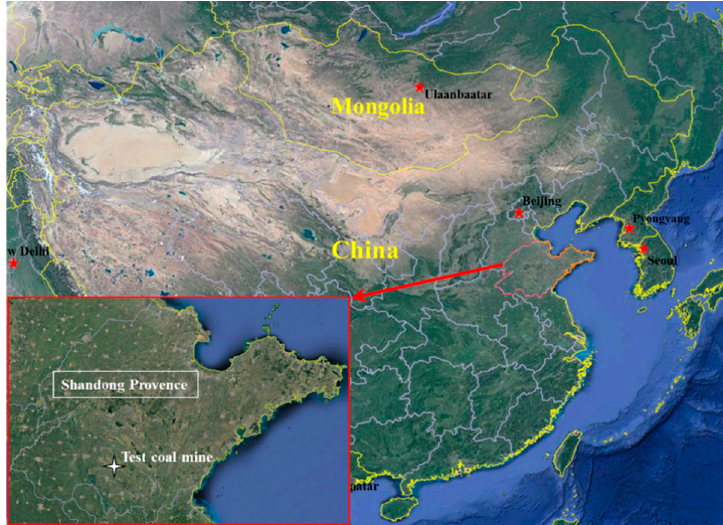
Figure 2. Schematic diagram of test stope.